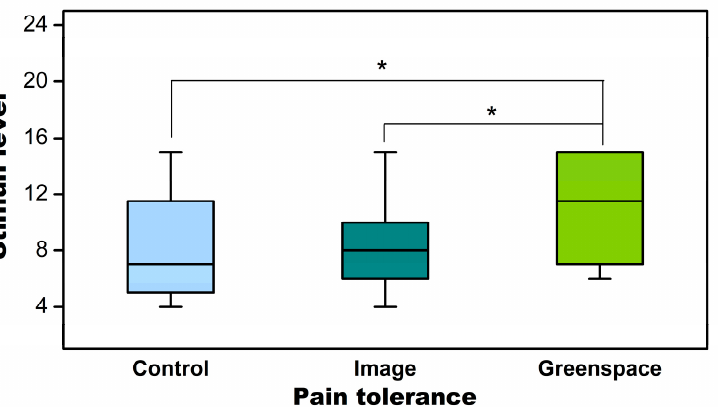
Figure 4. The differences in pain tolerance in non-responders between settings. *, p < 0.05, adjusted by Bonferroni correction.